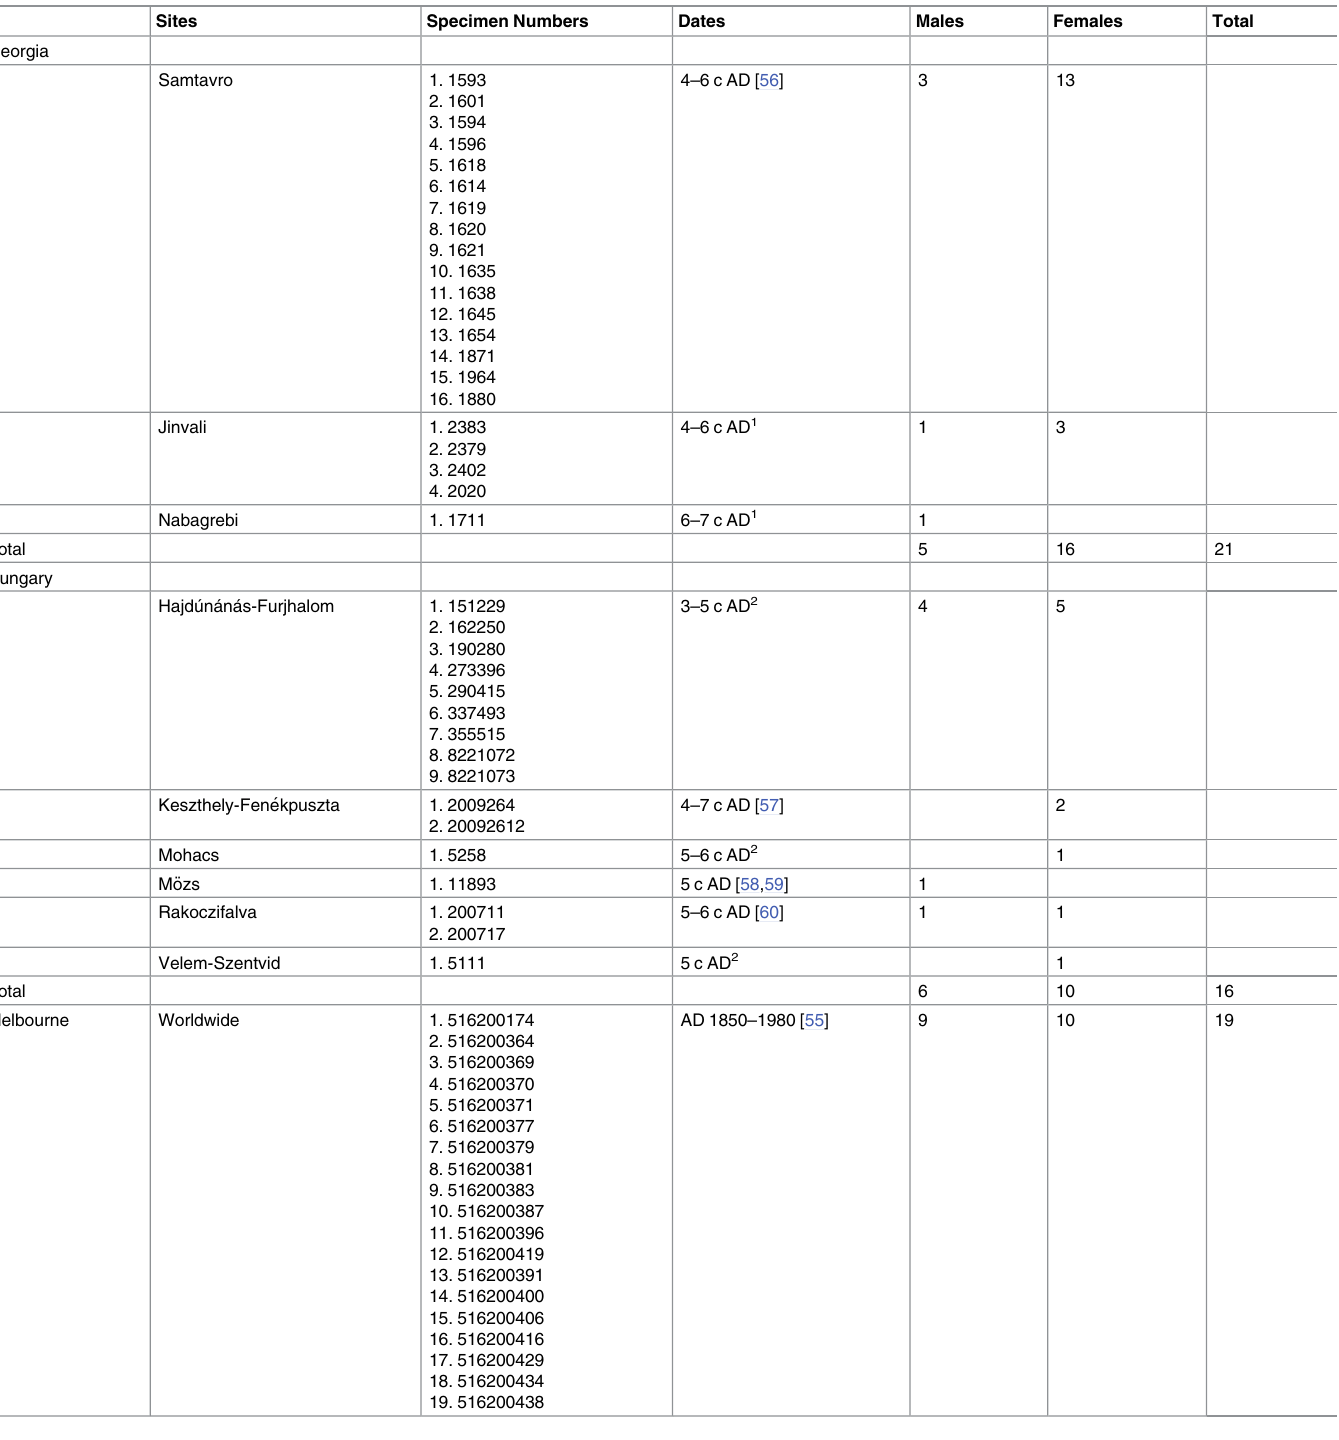
Table 1. Materials used in the